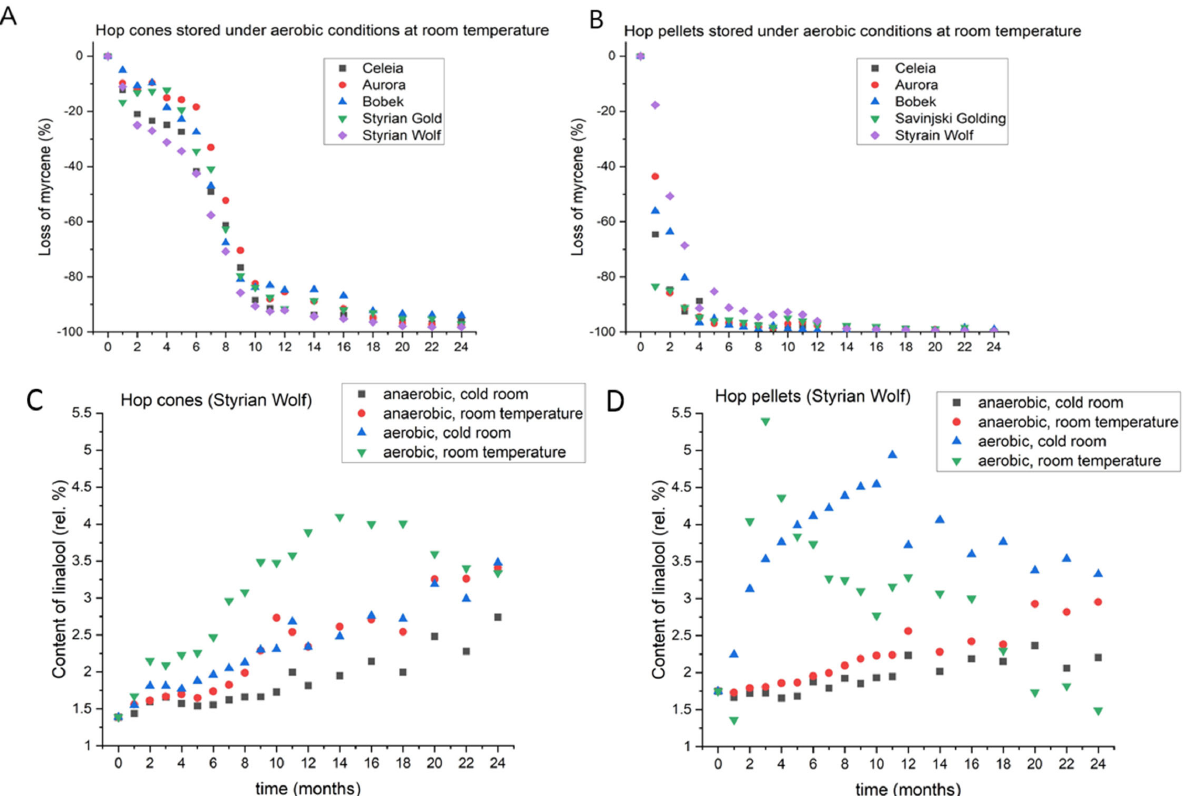
Figure 5. Loss of myrcene in cones ( A ) and pellets ( B ) stored under aerobic conditions at room temperature and changes in the content of linalool in Styrian Wolf cones ( C ) and pellets ( D ) during two-year period, under different storage conditions.